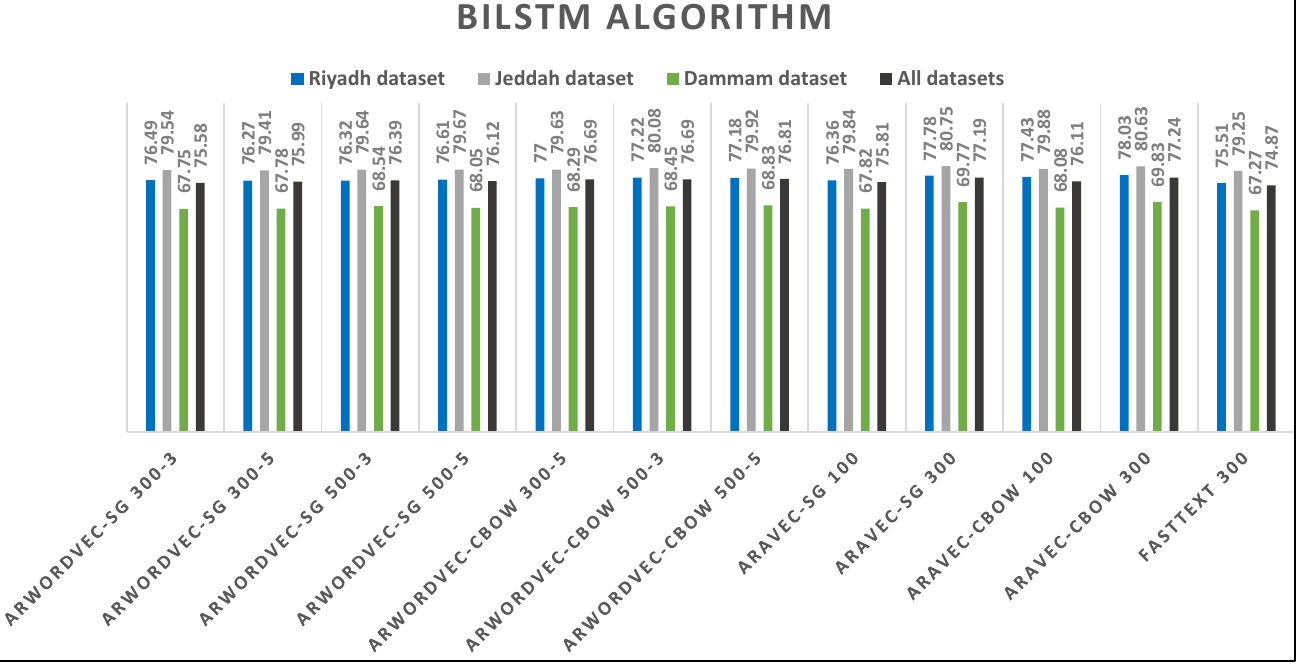
Figure 10. The Accuracies metric of BiLSTM algorithm for comparing different Arabic pre-trained word embedding techniques for the dataset during the COVID-19 pandemic.